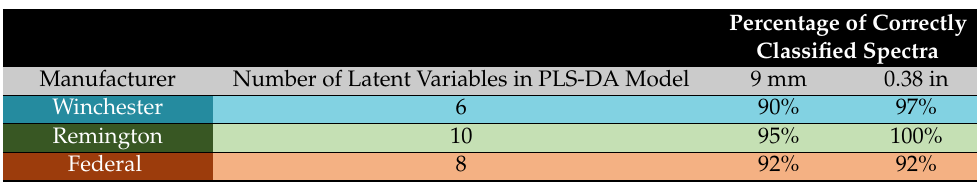
Table 6. Summary of the results of the caliber differentiation models detailed in Table 5 in percentage